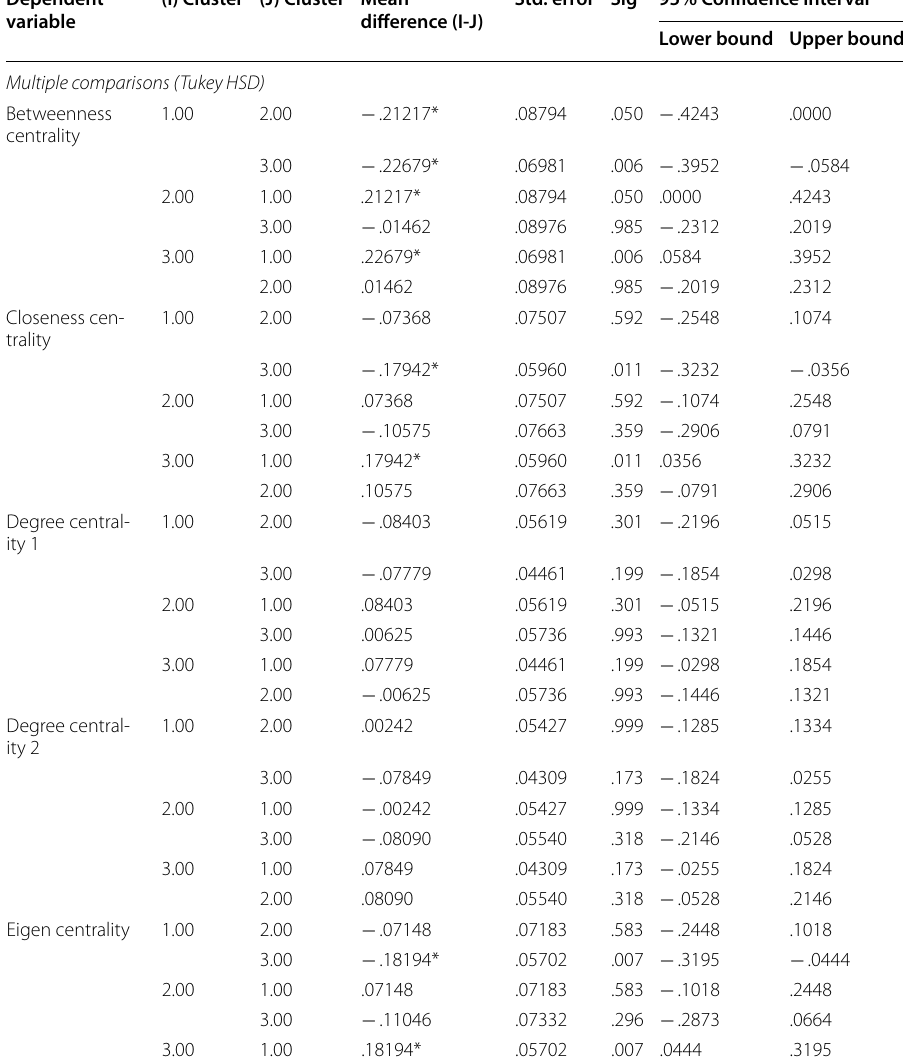
Table 10 The results of post-hoc Tukey HSD tests Dependent